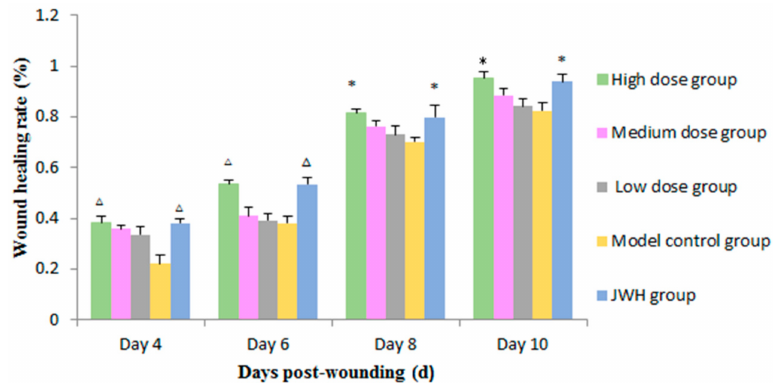
Figure 3. Effects of total flavonoids from B. balsamifera on wound healing rate of rats. Values are expressed as mean ± SD ( n = 6) as compared to the control group, * p < 0.05, ∆ p < 0.01.